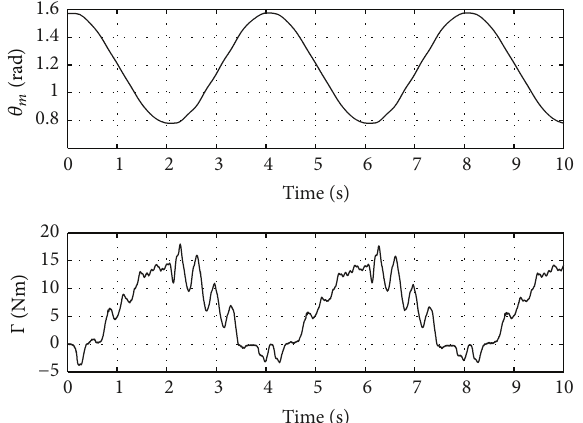
Figure 5: Experiment type 2: motor position and torque measure- ment for mass 𝑚 2 .